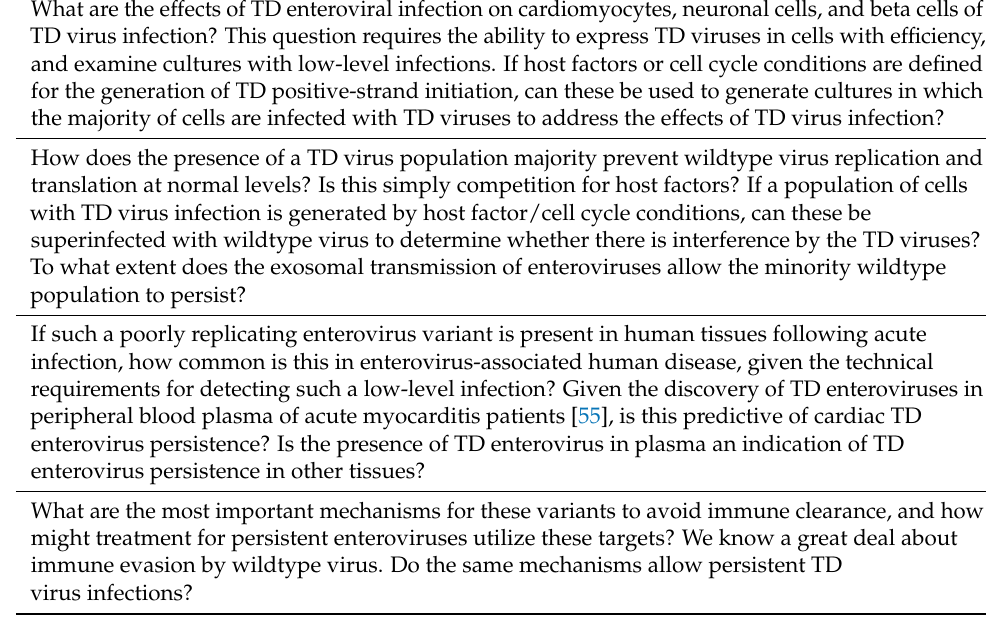
Table 1. Cont. What are the effects of TD enteroviral infection on cardiomyocytes, neuronal cells, and beta cells of TD virus infection? This question requires the ability to express TD viruses in cells with efficiency, and examine cultures with low-level infections. If host factors or cell cycle conditions are